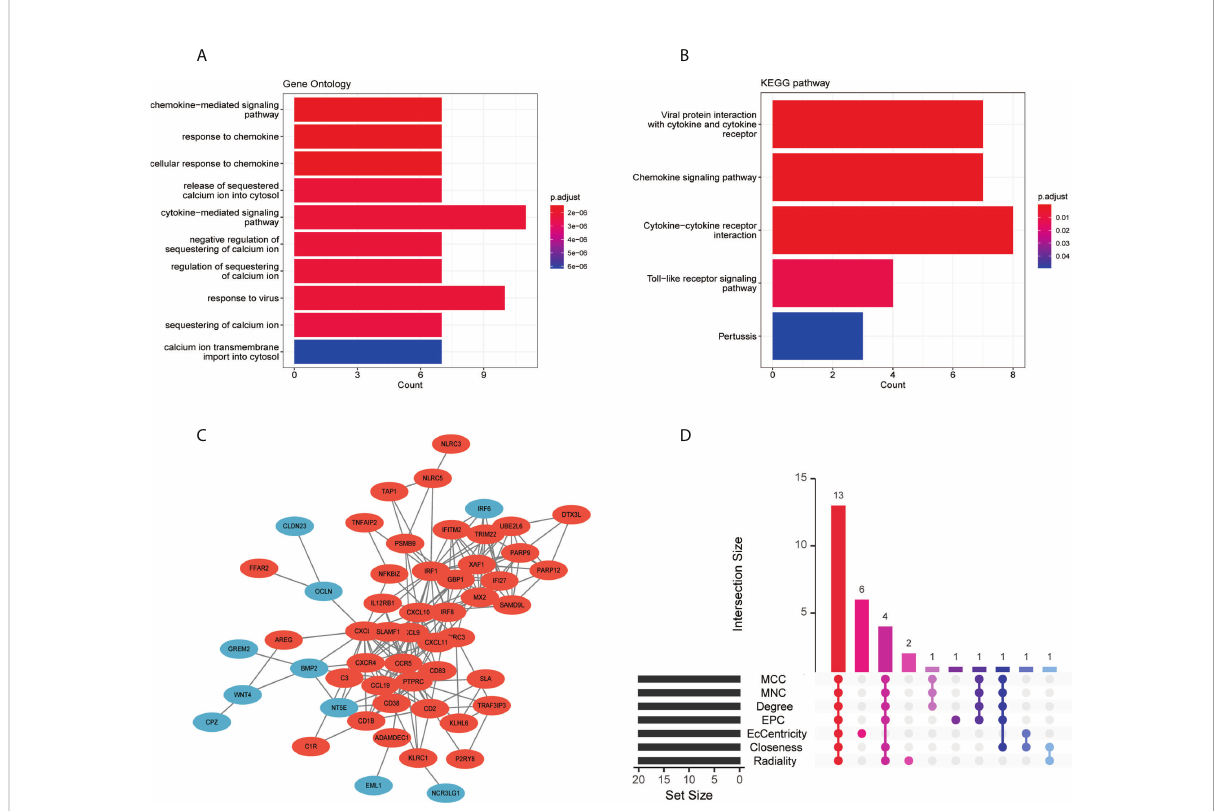
FIGURE 5 Functional enrichment analysis, PPI network, and screening of hub genes: (A) GO enrichment analysis of co-DEGs, (B) KEGG enrichment analysis of co-DEGs, (C) PPI network of co-DEGs, and (D) screening of hub genes showed by the upset diagram of seven algorithms. DEGs, differentially expressed genes; GO, gene ontology; KEGG, Kyoto Encyclopedia of Genes and Genomes; PPI, protein-protein